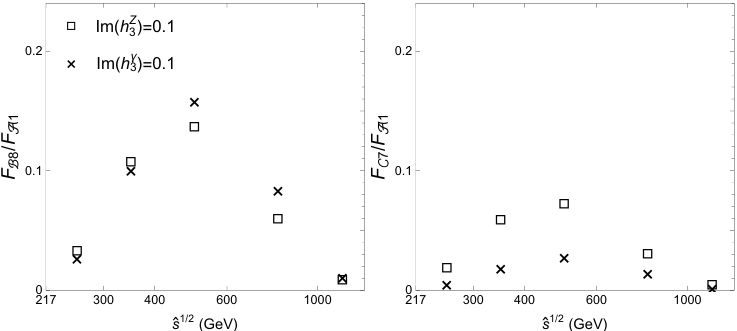
(left panel) and F (right panel) divided by F are shown in B 8 C 7 A 1 = 0 + 0 : 1 i , and points give those for 3 (cid:2)